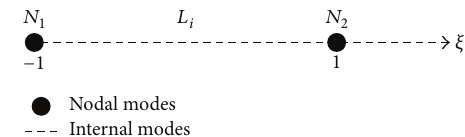
Figure 1: One-dimensional element on standard domain.